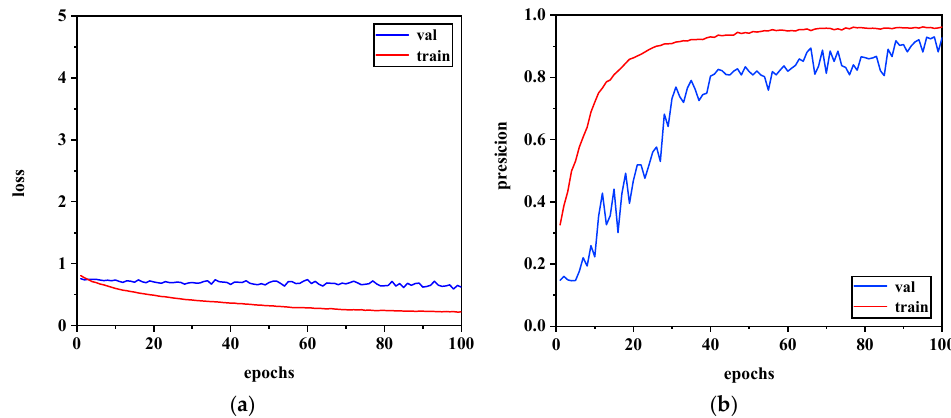
Figure 12. The curve changes of training set and validation set during the training of 3D point cloud network. ( a ) Loss curve; ( b ) precision curve.